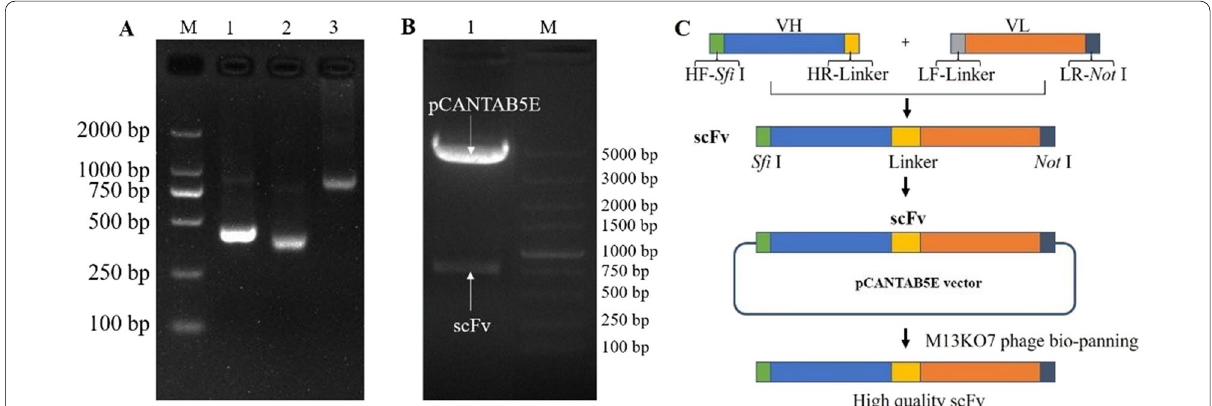
Fig. 2 Construction of the IgY-scFv antibody phage display library. A PCR products of V H (420 bp, lane 1), V L (370 bp, lane 2) and scFv (800 bp, lane 3). B Double restriction digestion result of pCANTAB5E-scFv recombinant plasmid. C Schematic diagram of scFv construction. M: DNA marker (TaKaRa, Dalian, China)